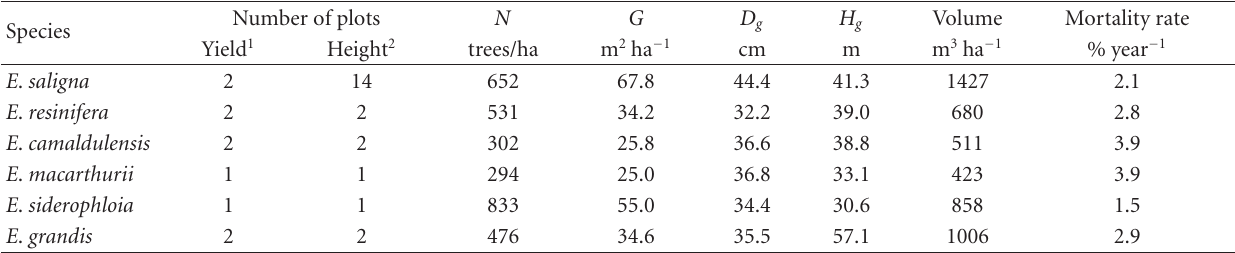
Table 1: Stand characteristics of six tropical Eucalyptus species at 43 years in the Tchianga experiment. The last column shows the mean annual mortality rate. Number of plots N H g Volume Mortality rate Species